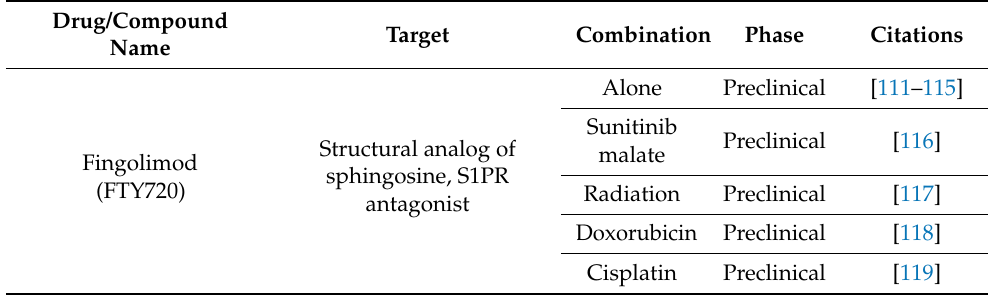
Table 2. List of ceramide-based therapeutics in preclinical and clinical studies in breast cancer.